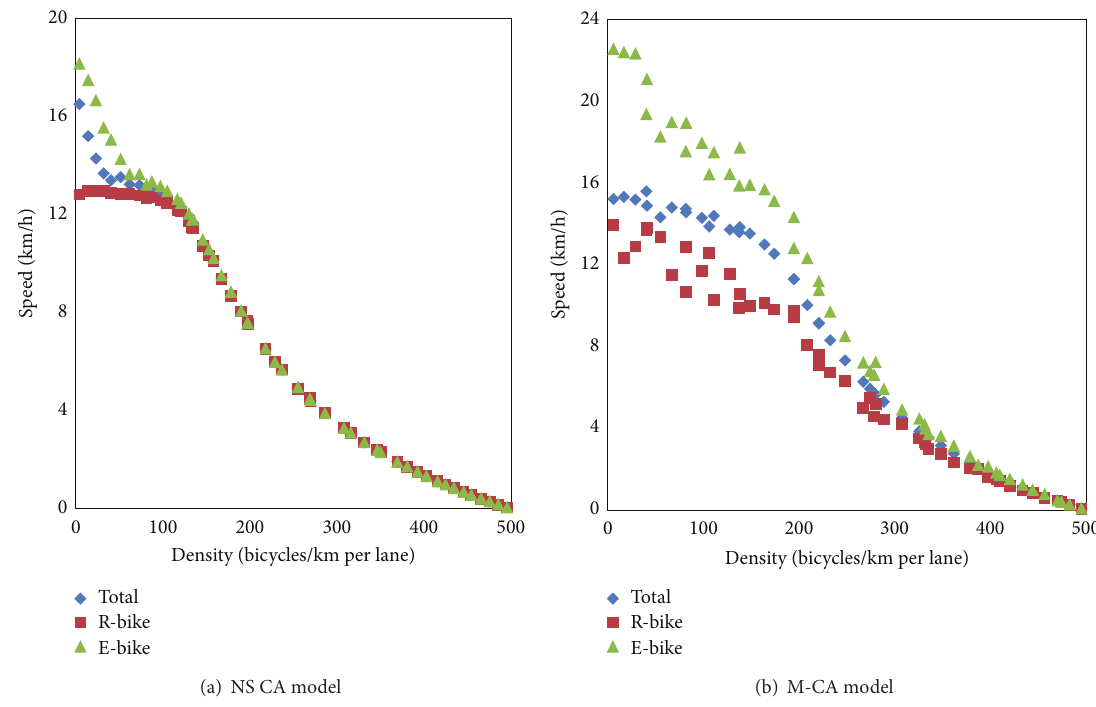
Figure 6: Speed-density relationships for different bicycle